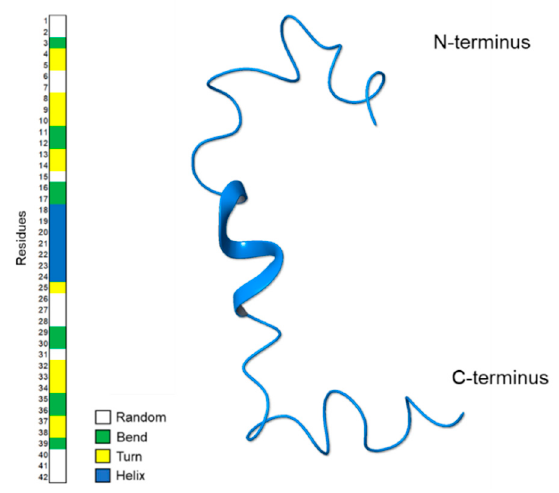
Figure 4. Ribbon representation of the most representative NMR structure of A β (1–42) acquired in HFIP/water 50/50 v/v . On the left, the Define Secondary Structure of Proteins (DSSP) plot calculated by GROMACS do_dssp .